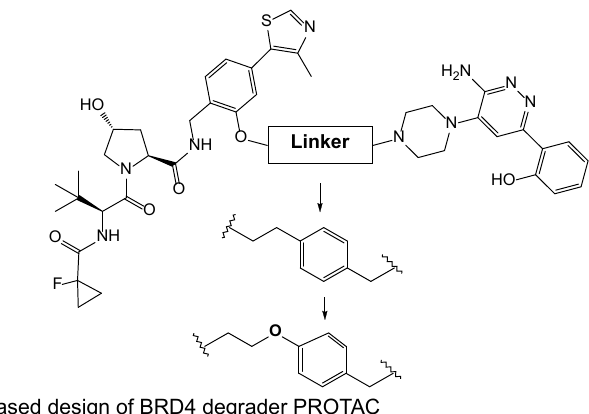
Figure 4. Rational structure-based design of BRD4 degrader